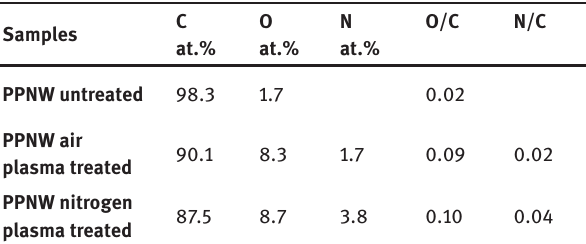
Table 1: Surface composition of the untreated and plasma treated polypropylene